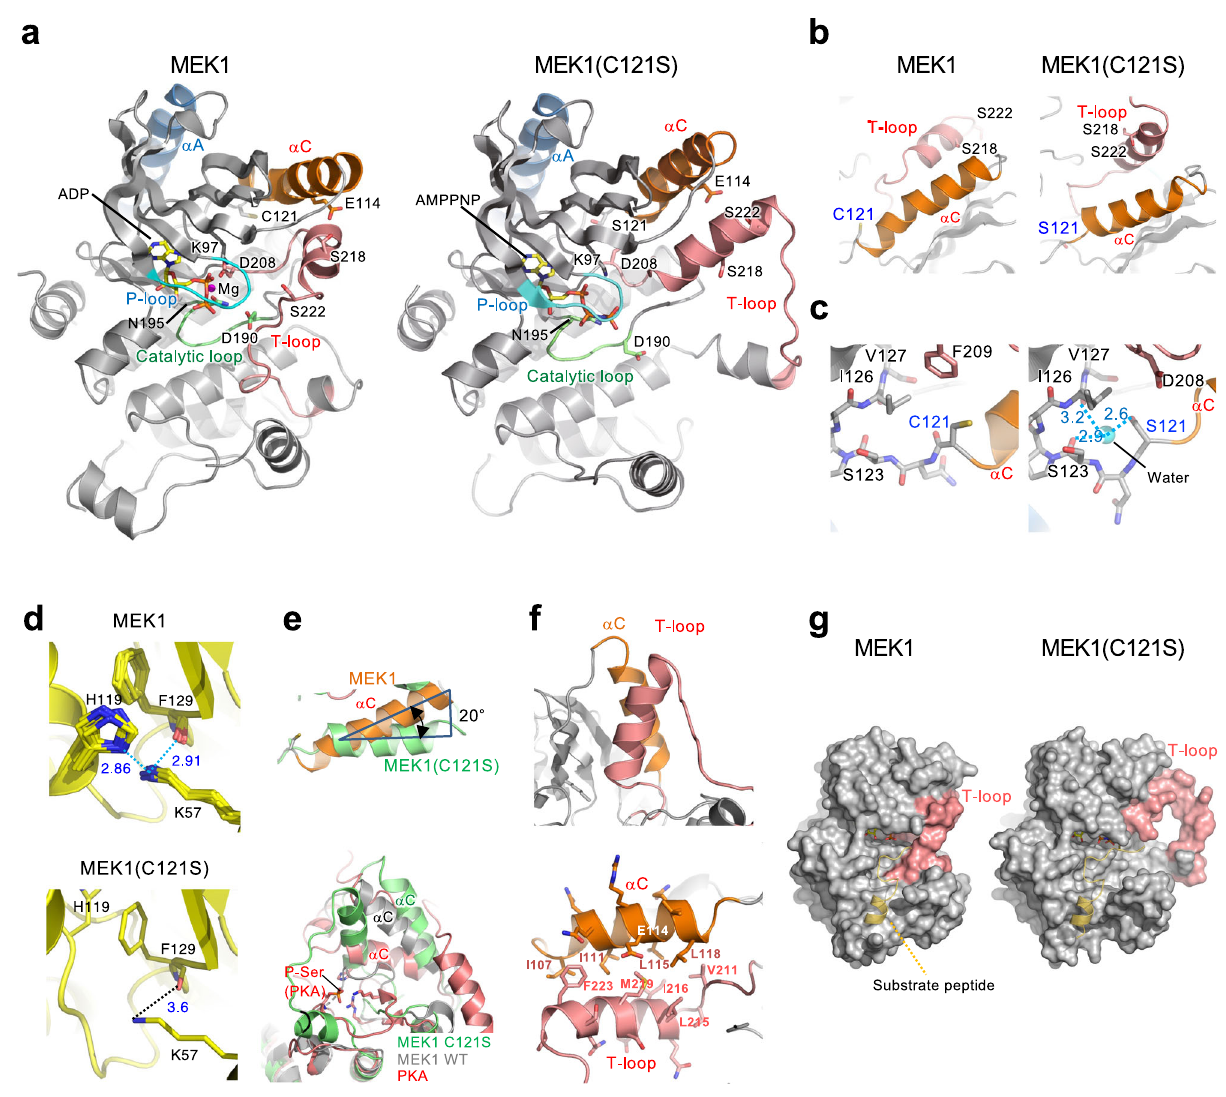
Fig. 2 Structural basis for an activating MEK mutation. a Overall crystal structures of MEK1 (PDB:3EQI) and MEK1(C121S) are shown as ribbon diagrams. Color coding: dark blue, helix A ( α A); orange, helix C ( α C); pink, T-loop; cyan, P-loop. The positions of key residues are shown. b Close-up views of the helix C and T-loop in MEK1 and MEK1(C121S). c Local structures around WT C121 and the mutated S121. Cyan sphere, water molecule; light-blue dotted lines, H- bonds; numbers, distances in (Å). d MEK1(C121S) mutation disrupts the interdomain hydrogen (H)-bonds connecting residues H119 and F129 with K57. Superposition of the interdomain H-bonds in 14 MEK1 structures (upper) and the corresponding area in MEK1(C121S) (lower) are shown. c , d Nitrogen and oxygen atoms are colored blue and red, respectively. The numbers beside the dotted lines represent distances (Å). e Excessive outward rotation of the MEK1(C121S)-helix C. (Upper) The helix C structure of MEK1(C121S) (green) is superimposed on that of MEK1 WT (orange, PDB: 3SLS). The helix C of MEK1(C121S) is rotated out by 20 degrees relative to that of MEK1 WT. (Lower) Superposition of the C helices of MEK1(C121S) (green), MEK1 WT (grey, PDB: 3SLS), and active PKA (red, PDB: 1ATP). f Antiparallel coiled-coil interactions between the helix C and the T-loop in MEK1(C121S). (upper) The helix C interacts with a part of the T-loop that forms a helix. (lower) Residues forming hydrophobic contacts are shown. g Space- fi lling models. A PKA substrate peptide (yellow, PDB: 4HPU) is superimposed on the MEK1 MEK inhibitor, hymenialdisine 23 , can more potently inhibit